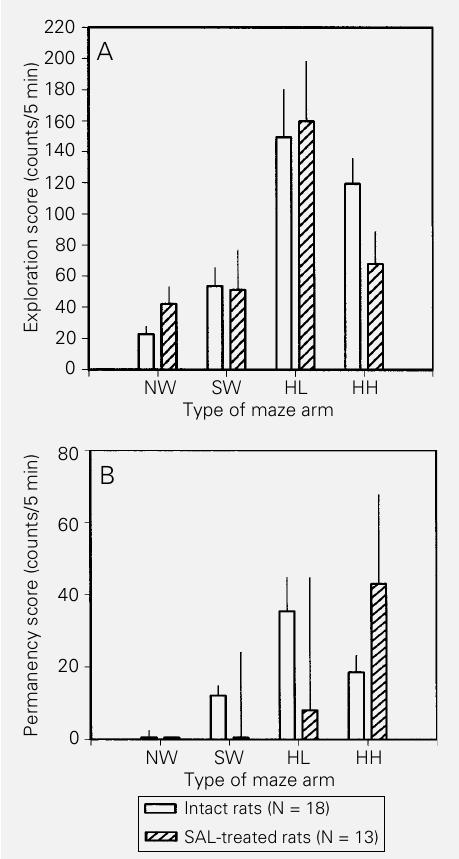
Figure 2 - Exploration (A) and permanency (B) scores in the asymmetric plus-maze of intact and implanted rats microinjected into the hippocampus with 1 µl of saline solution (SAL). Results are reported as the median ± standard error of the